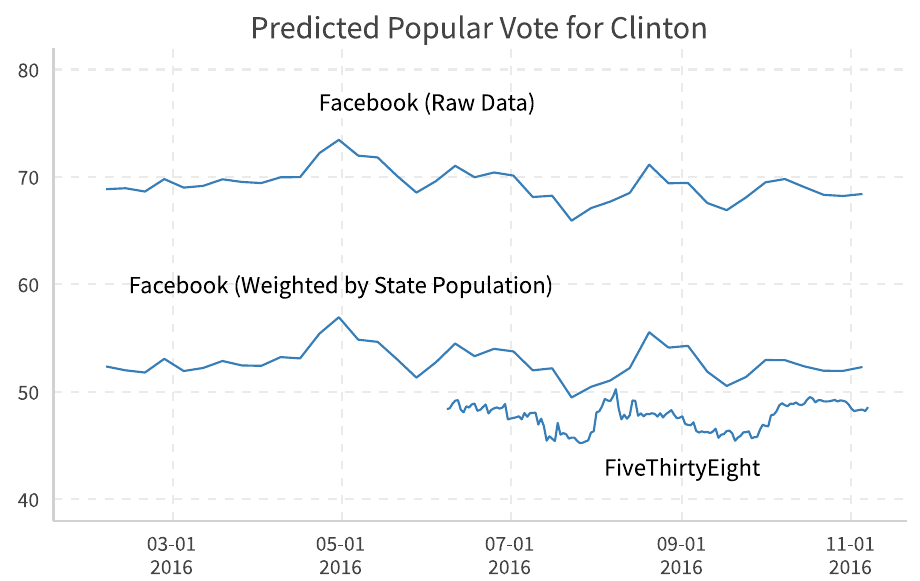
Fig 15. Forecasting popular vote for clinton. Facebook (Raw Data): Calculated using all US political users that have closer ideological positions to Clinton. Facebook (Weighted by State Population): Calculated using the population in each state from [23], multiplied by Facebook support rates in each states. FiveThirtyEight: “Nowcast” from [27]. States are guessed by the maximum state on likes of national politicians (Sen, Rep, Gov). Data used: 2016-10-01 to 2016-11- 07.